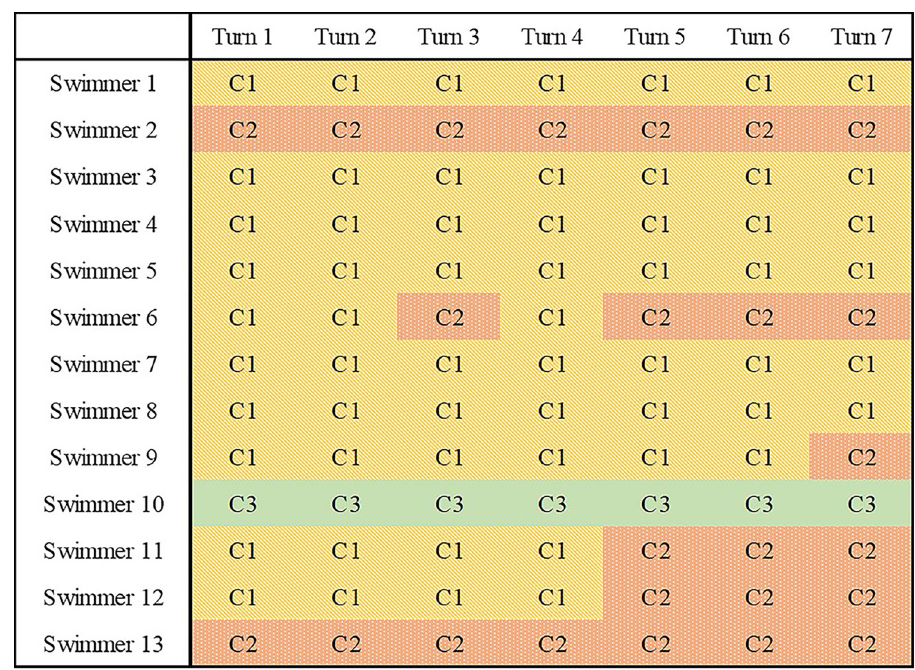
Fig 2. Coordination patterns observed during each turn for all swimmers.